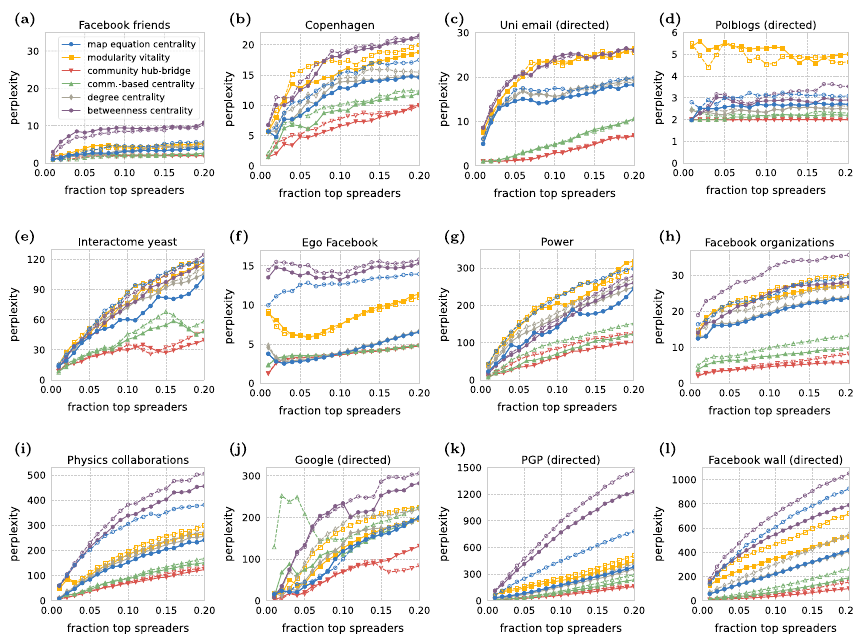
Fig. 8 Perplexity for the distribution of selected nodes as a function of the fraction of selected top spreaders for map equation centrality, modularity vitality, community hub-bridge, community-based centrality, degree centrality, and betweenness centrality in twelve empirical networks. Community structures are identified with Infomap; solid lines use the unrecorded link teleportation flow model, dashed lines use recorded node